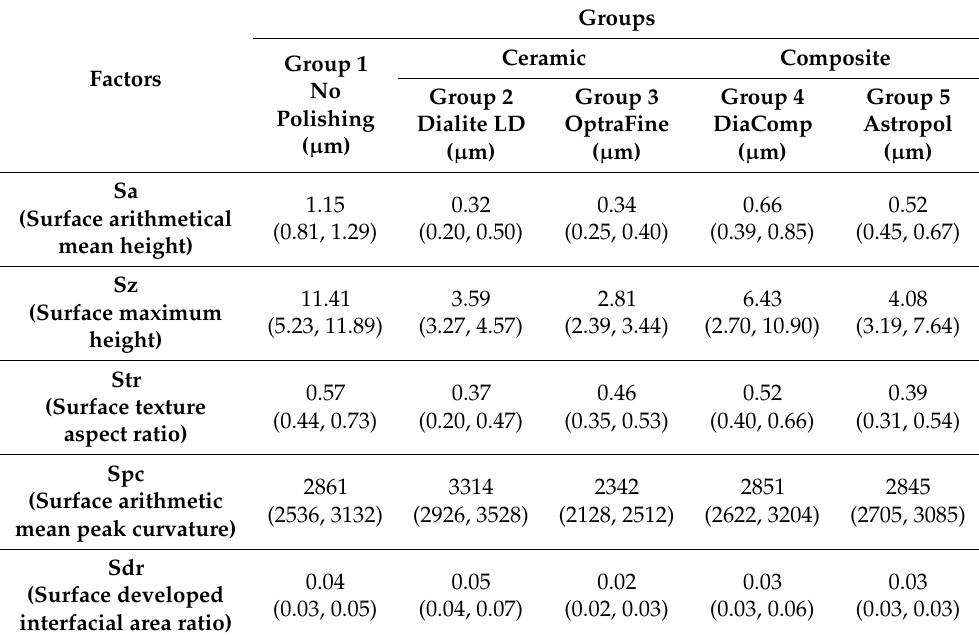
Table 2. Results for comparing ceramic and composite polishing systems for chairside CAD/CAM reinforced lithium disilicate